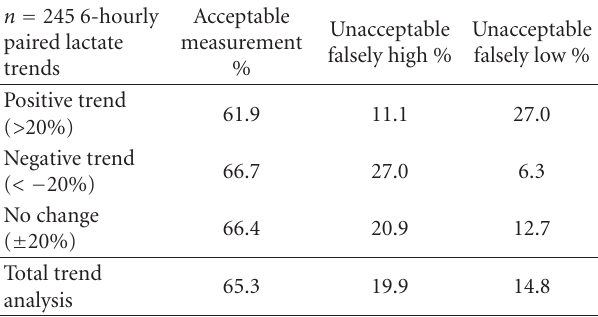
Table 3: Clinical evaluation of 6-hour lactate trend analysis from subcutaneous adipose tissue ( Δ sat LAC) versus arterial blood ( Δ art LAC). Lactate measurements are stratified to positive, stable and negative lactate trends as indicated in Figure